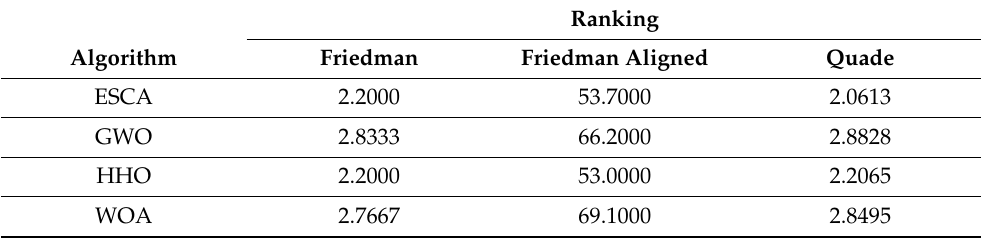
Table 20. Comparison of solution accuracy for the assessed algorithms. The average ranking outcomes through Friedman, Friedman aligned, and Quade tests.